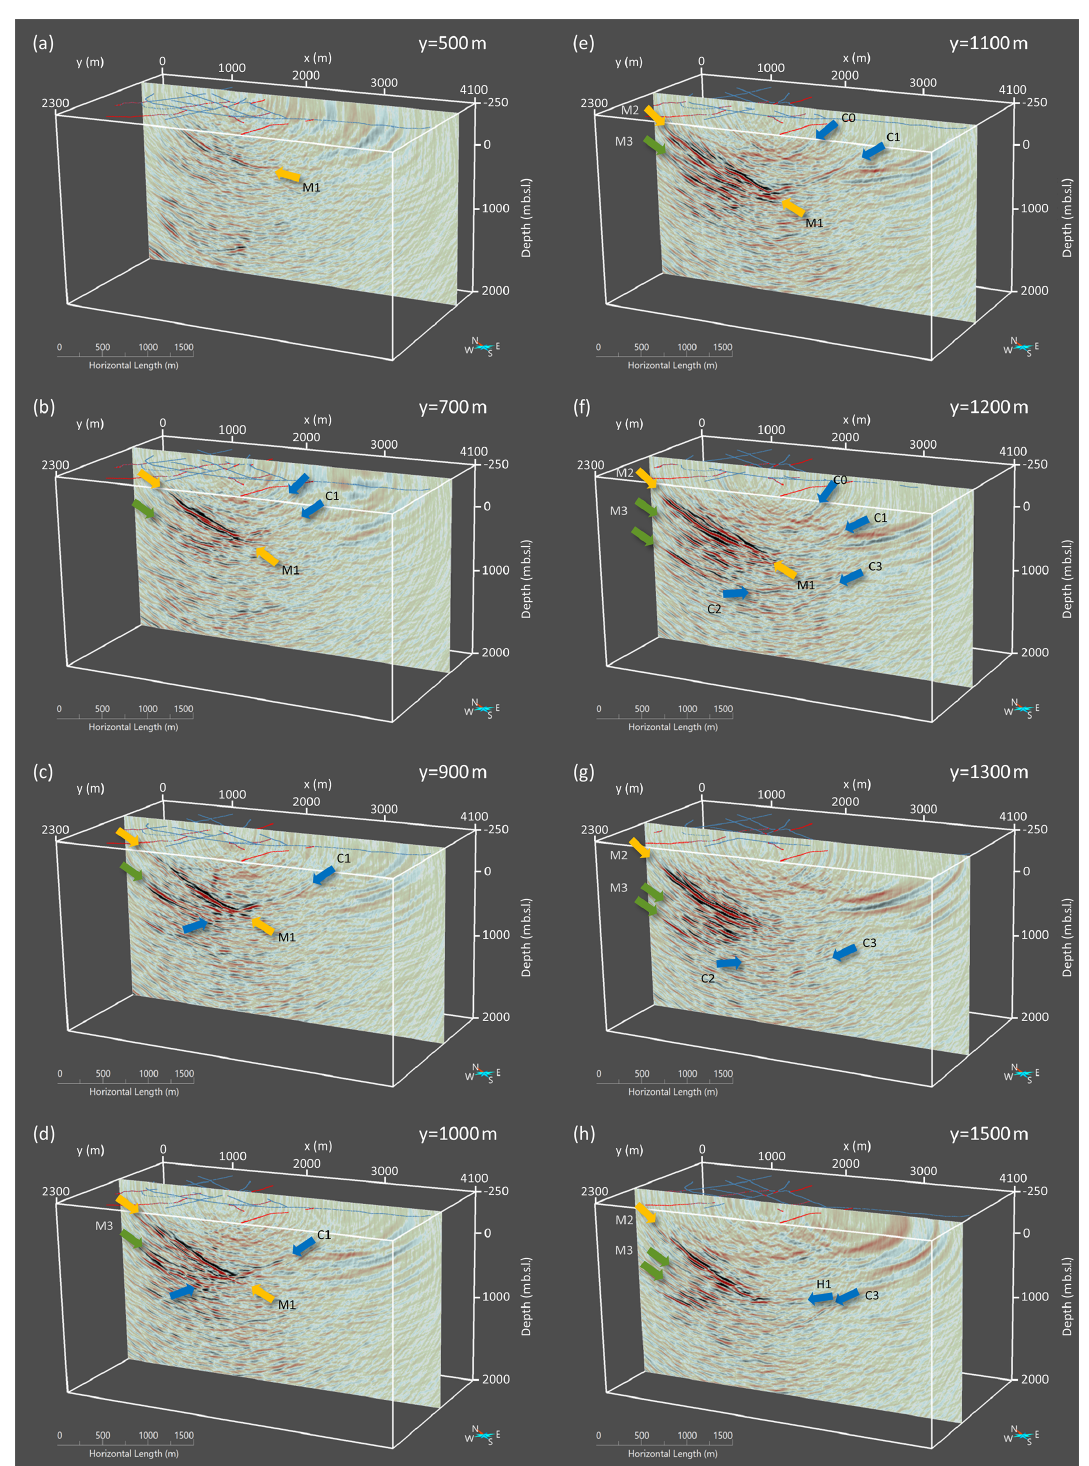
Figure 8. Depth slices through the final FVM result based on the 1D migration velocity model. The sections in (a) to (h) are spaced by 100–200m in the y direction. Several reflectors are named and marked with arrows: yellow marked reflectors correspond to the known min- eralization, reflectors marked with green arrows are located subparallel below the known mineralization, and blue arrows indicate reflectors dipping into the opposite direction of the known